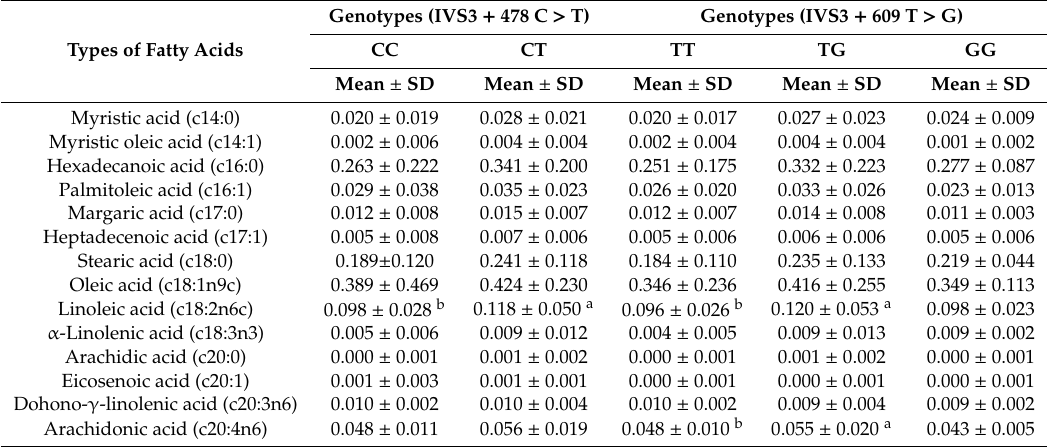
Table 4. The correlation analysis of DLK1 gene SNPs with the fatty acids composition in the longissimus muscle of Chinese Simmental